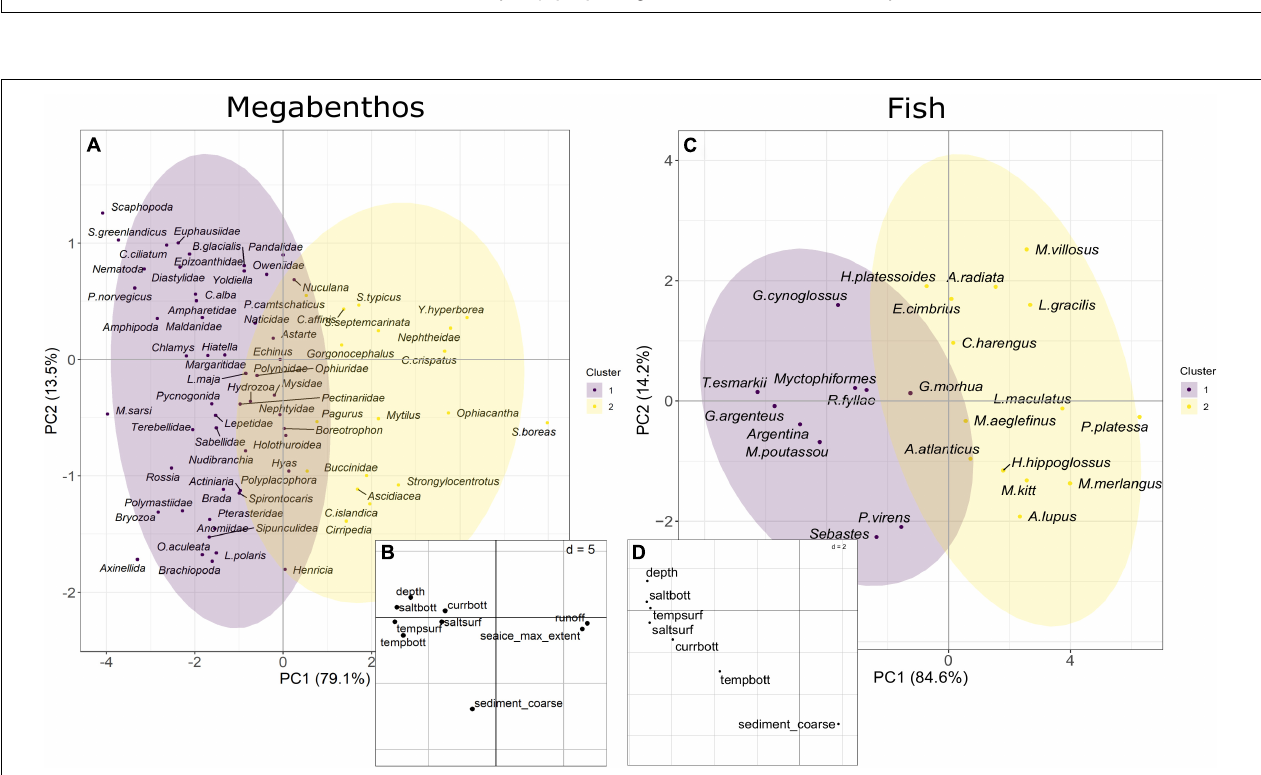
FIGURE 4 | Compromise analysis for megabenthos and fish. (A,C) The space of the taxa and (B,D) the space of the environmental variables.